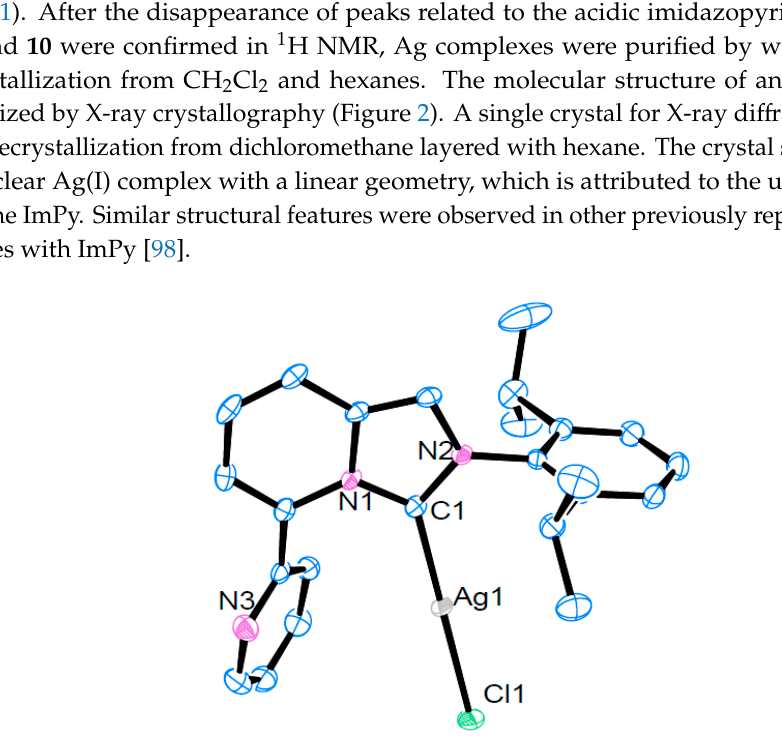
Figure 2. Molecular structure of 5 . Thermal ellipsoids are set at 50% probability. Hydrogen atoms have been omitted for clarity.